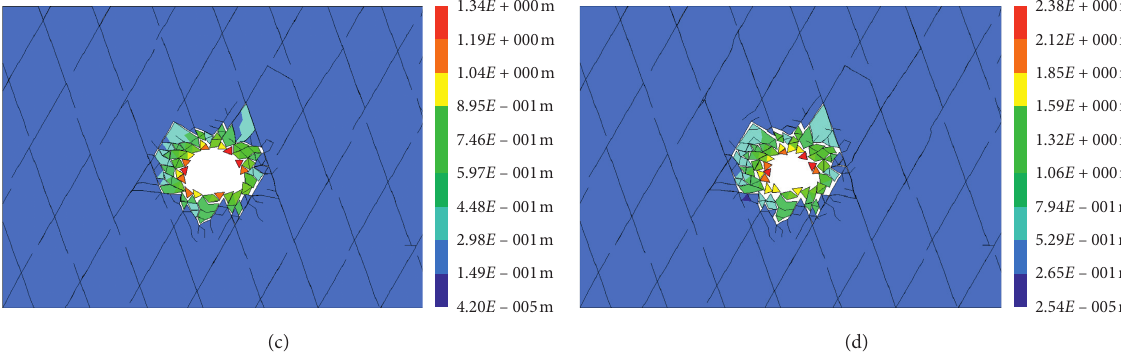
Figure 11: The failure process of Xiucun tunnel under multiple blasting loads. (a) Displacement distribution at 0.005 s.(b) Displacement distribution at 0.04s. (c) Displacement distribution at 0.12s.(d) Displacement distribution at 0.2s.